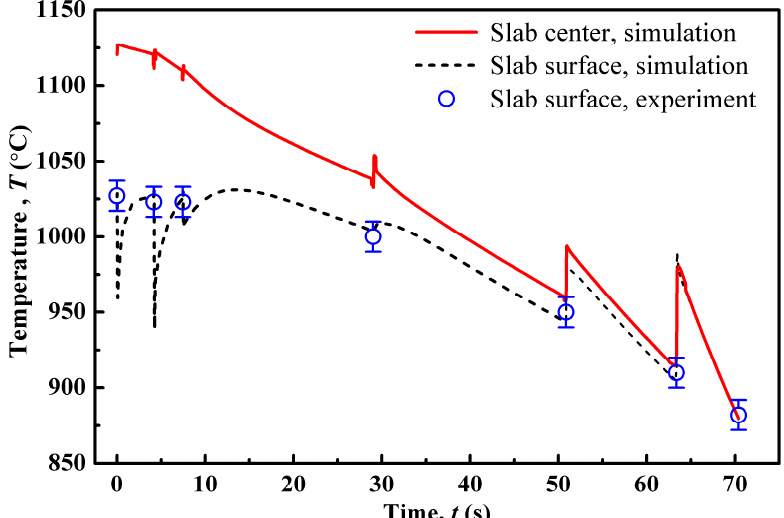
Figure 2. FEM-simulated temperatures of slab center (red line) and surface (black dash line) vary- ing with time compared with the experimentally measured slab surface temperatures (blue circle).